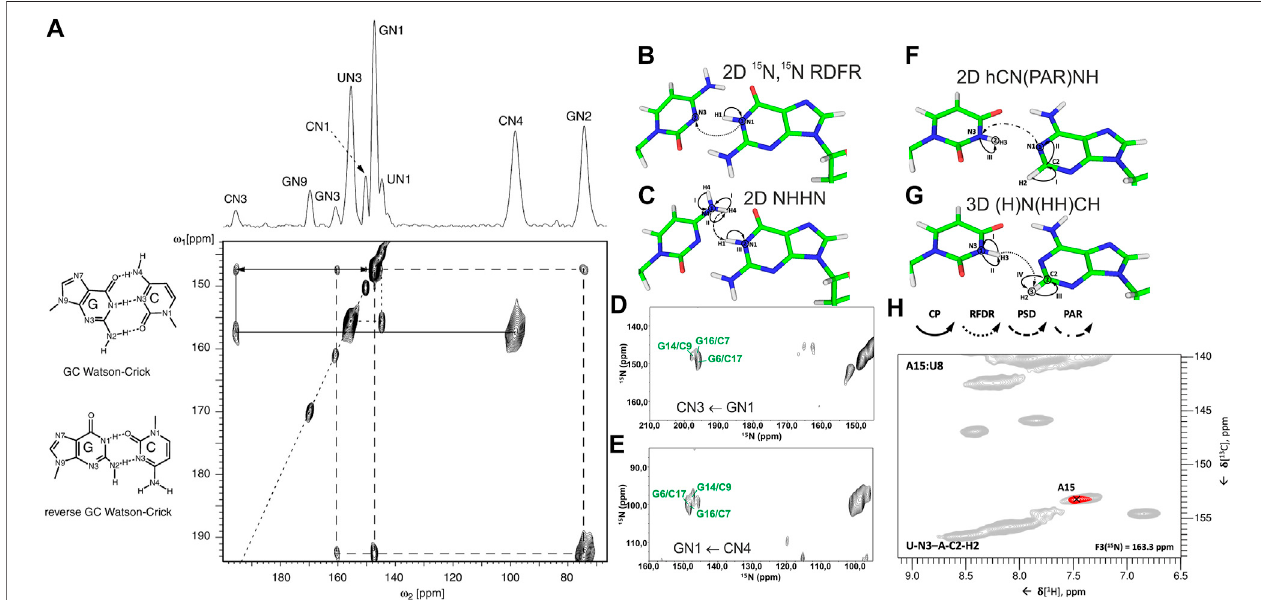
FIGURE 2 | Base pair identi fi cation and spin system – speci fi c assignment of imino nitrogens by ssNMR. (A) Identi fi cation of WC G:C base pair in (CUG) 97 RNA repeat by 15 N, 15 N RFDR experiment (Leppert et al., 2004). Magnetization transfer schemes for (B) 15 N, 15 N recoupling (RFDR, PAR) experiment and (C) NHHN experiment shown on the example of WC G:C base pair. (D) 2D 15 N, 15 N RFDR and (E) 2D NHHN spectra of G,C lab 26mer box C/D RNA showing three assigned WC G:C base pairs (Marchanka et al., 2015). Magnetization transfer schemes for (F) 2D hCN(PAR)NH (Yang et al., 2017) and (G) 3D (H)N(HH)CH (Aguion et al., 2021) experiments (H) Representative2Dplanefromthe3D(H)N(HH)CHspectrumshowsWCbasepairA15:U8in26merBoxC/DRNA. 15 NfrequencyofN3nitrogeninuracil is indicated. In magnetization transfer schemes, solid arrows indicate CP transfers, dotted arrows indicate homonuclear RFDR recoupling, the dashed arrow indicates PSD transfer, and the dash-dotted arrow indicates PAR transfer; Roman numbers indicate CP transfers; Arabic numbers correspond to the spectral dimensions (t 1 – t 3 ). Figure (A) is reproduced from J. Leppert, C. R. Urbinati, S. Häfner, O. Ohlenschläger, M. S. Swanson, M. Görlach, and R. Ramachandran, Identi fi cation of NH...N hydrogenbondsbymagicanglespinningsolidstateNMRinadoublestrandedRNAassociatedwithmyotonicdystrophy.NucleicAcidsRes.,2004,32,3,1,177 – 1,183, by permission of Oxford University Press. Spectrum in (D) is adapted from (Marchanka et al., 2015). Spectrum in (E) is reprinted from (Marchanka and Carlomagno, 2019) with permission from